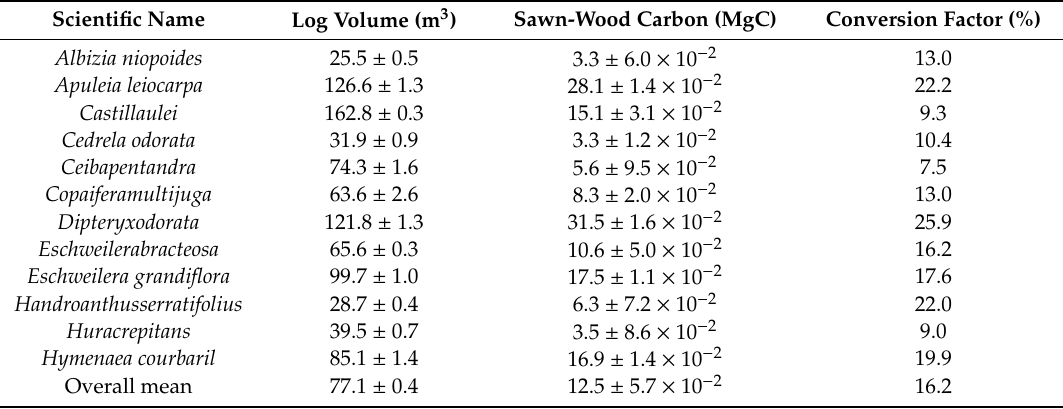
Table 7. Conversion factor (%) for converting log volume (m 3 ) to carbon (MgC) stored in sawn-wood products (mean ± standard error of the mean) for the 12 tree species sampled in a 1252.8-ha area harvested in a forest-management area in the state of Acre,